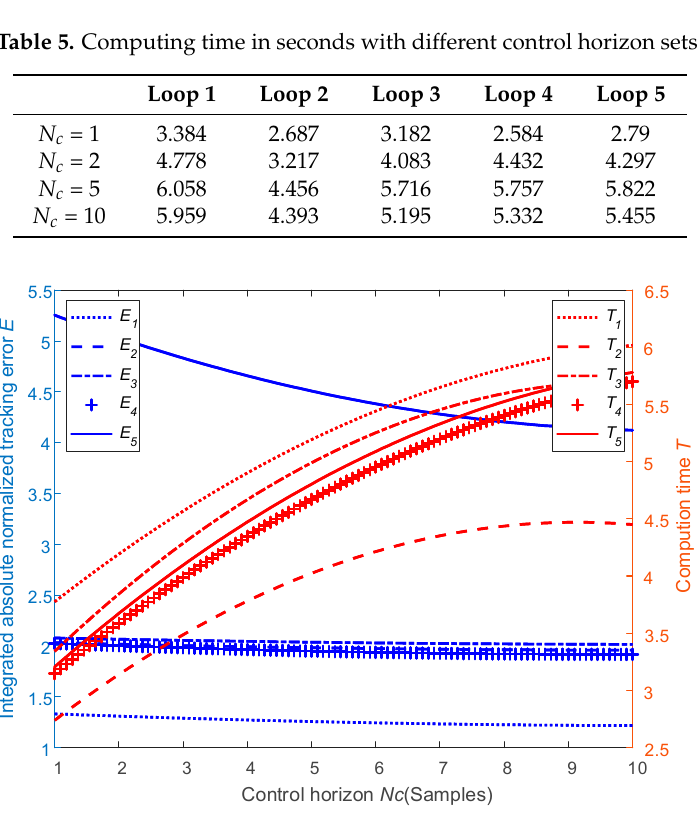
Table 4. Normalized tracking error with different control horizon sets. Table 4. Computing time in seconds with different control horizon sets.